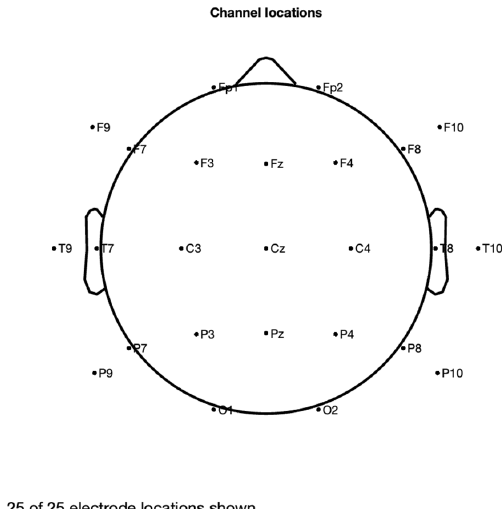
Figure 2. Channel locations.